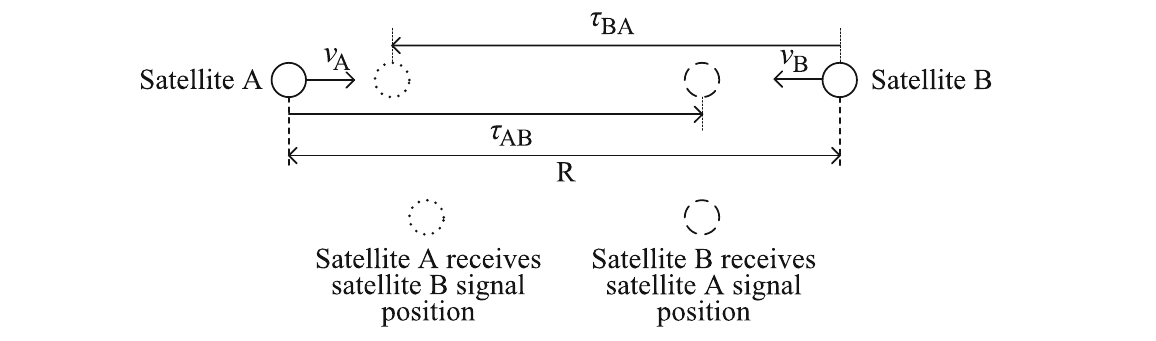
Fig. 2 Influence of inter-satellite mutual close on the measurement of inter-satellite two-way clock